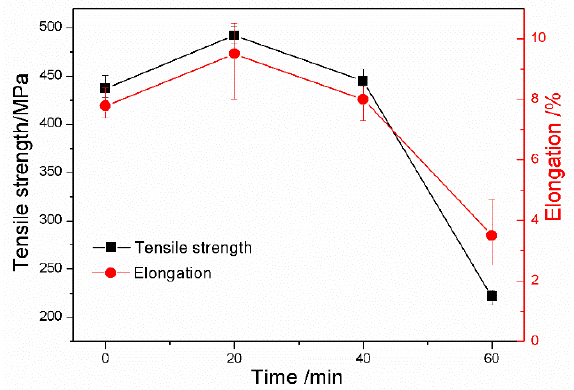
Figure 11. Tensile strength and elongation of DI after injecting nitrogen gas for different time periods.